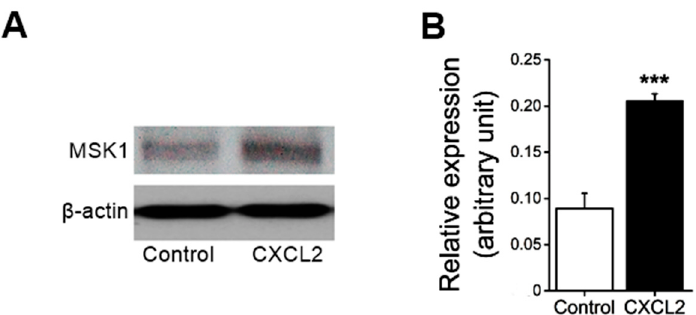
Figure 1. Effect of chemokine macrophage inflammatory protein-2 (CXCL2) on mitogen- and stress-activated protein kinase 1 (MSK1) expression in neutrophils. ( A ) Representative original Western blot and ( B ) means ± SEM ( n = 4) showing total MSK1 expression determined in 1-h saline-treated (Control) or CXCL2-treated (30 nM at 37 °C for 1 h) bone marrow neutrophils (relative to β -actin). *** ( p < 0.001) from the Control.